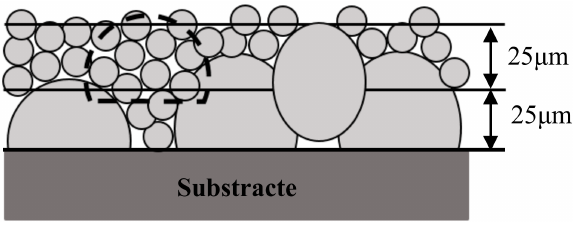
Figure 7. The schematic diagram of melt pool